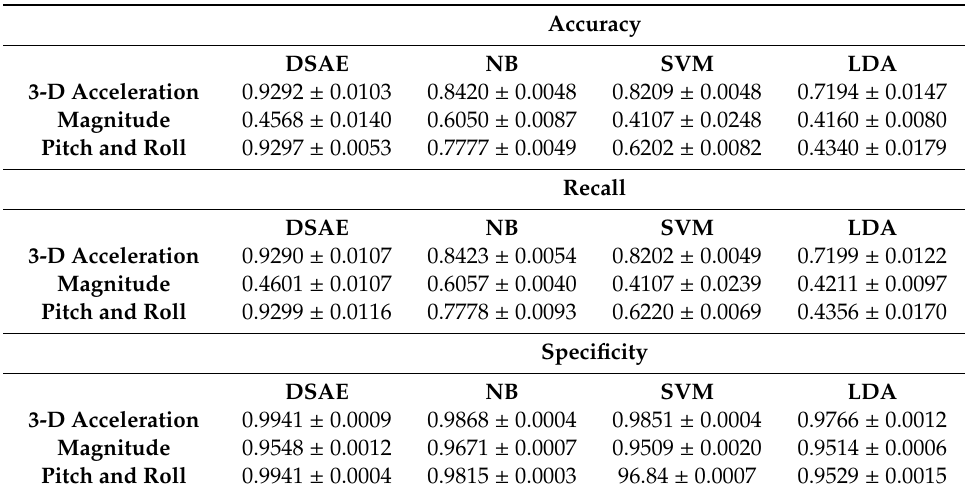
Table 4. Performance results using each